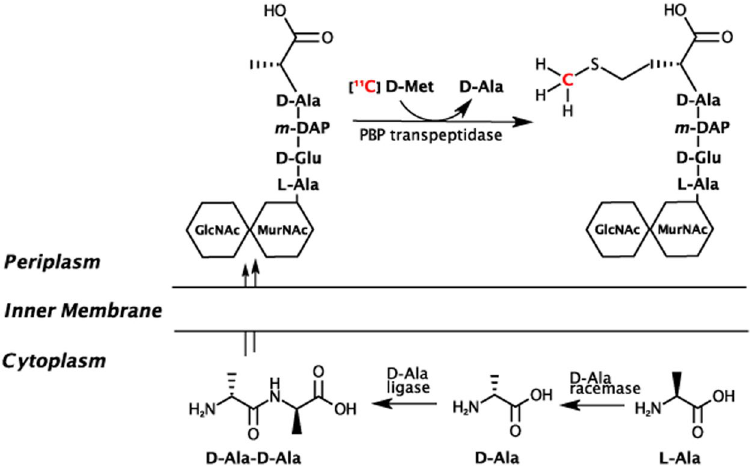
Figure 1. Incorporation of D-amino acids into peptidoglycan via racemase-dependent and racemase- independent pathways. The intracellular processing of D-alanine is contrasted with the perpiplasmic addition of D-methionine, which is “swapped” at the C-terminus of peptidoglycan, mediated by the transpeptidase domains of penicillin binding proteins (PBPs). D-Met may be incorporated into peptidoglycan muropeptides by exogenous administration or by physiologic production, with the latter associated with transition into the stationary phase and downregulation of peptidoglycan synthesis. The putative pathway of 11 C retention following [ 11 C] D-Met administration to infected animals is highlighted in red. GlcNAc =